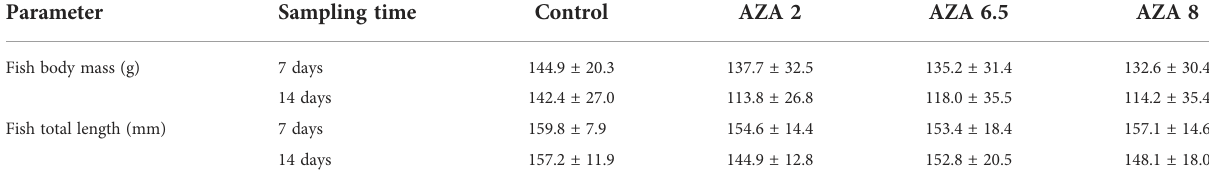
TABLE 2 Mean ± SD body mass (g) and total length (mm) of experimental fi sh measured after exposure (7 days) and recovery period (14